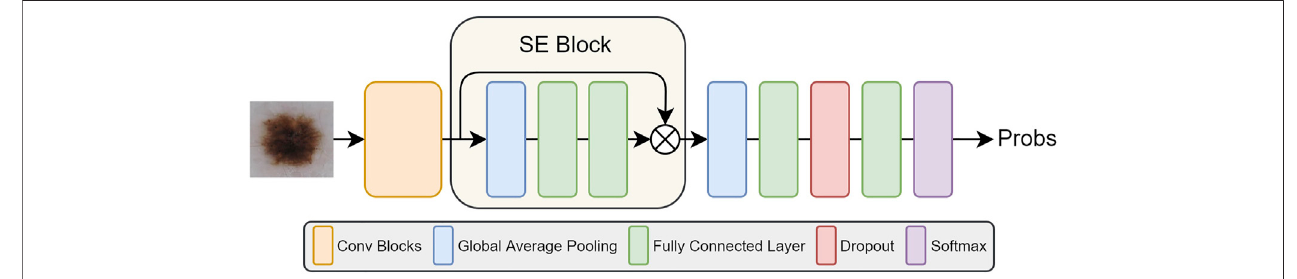
FIGURE 3 | The illustration of fi ve network structures after adding SE